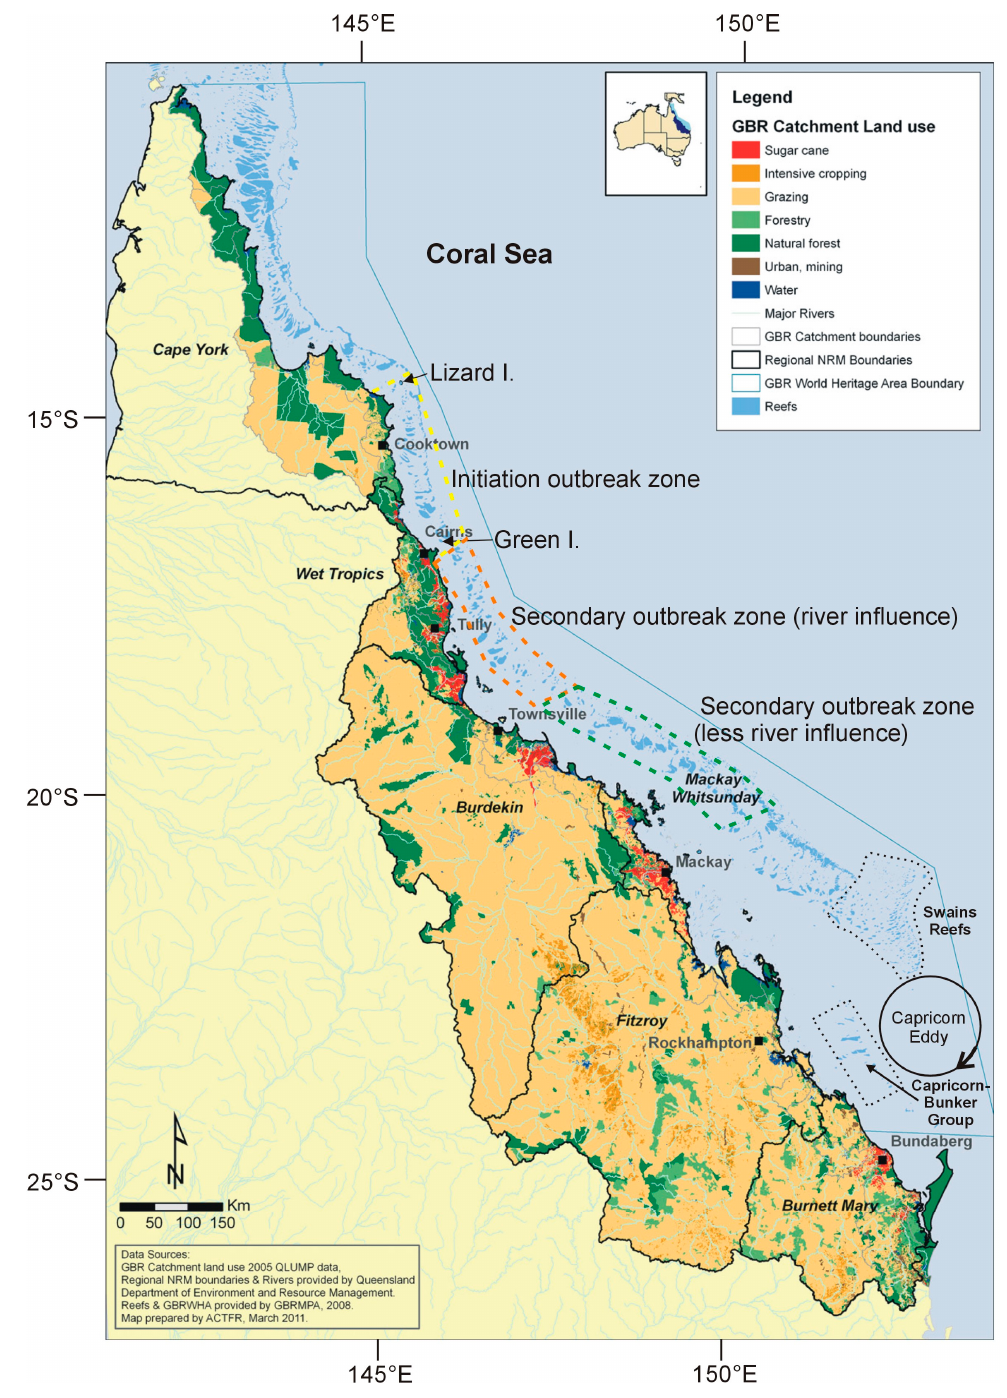
Figure 1. The Great Barrier Reef. The CoTS initiation zone is shown in yellow (dotted); the CoTS secondary outbreak zone strongly influenced by river discharge is shown in orange (dotted); the CoTS secondary outbreak zone weakly or not at all influenced by river discharge is shown in green (dotted).